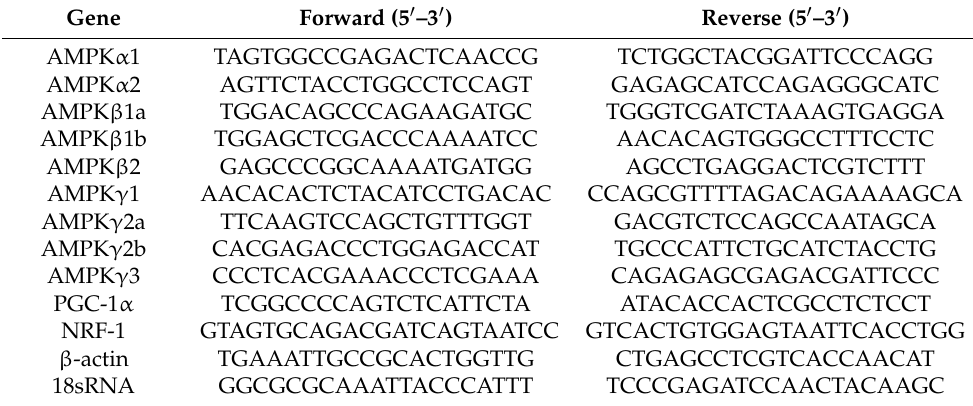
Table 1. Primer sequences used for PCR analysis. Gene Forward (5 (cid:48) –3 (cid:48)